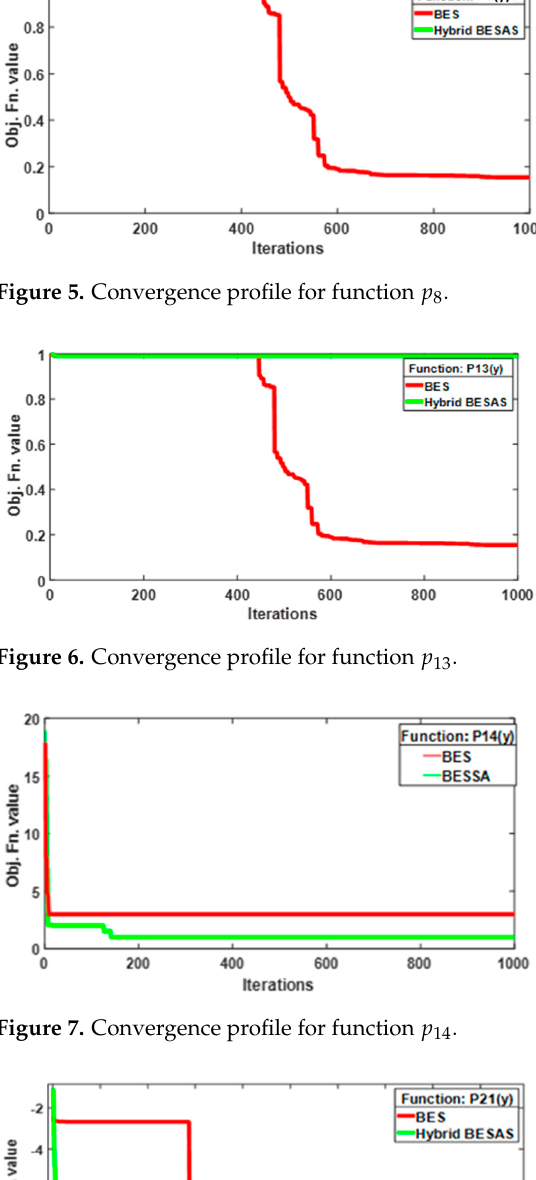
Figure 4. Convergence profile for function 𝑝 (cid:2873) .